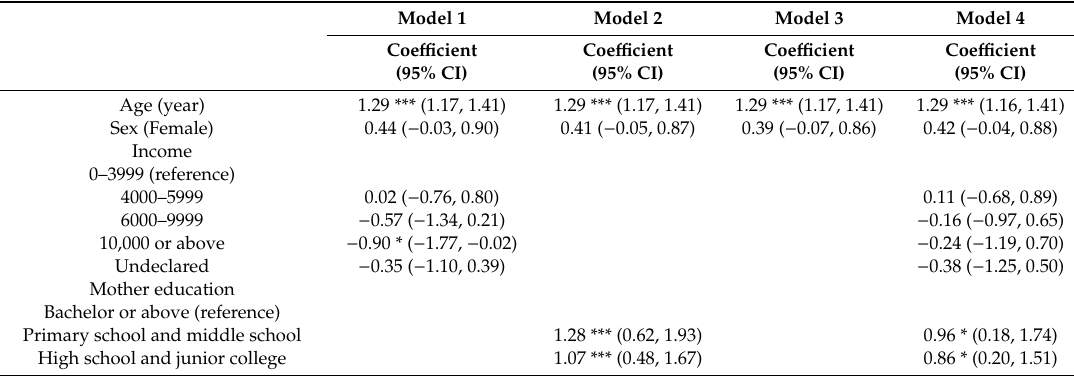
Table 2. Multilevel linear analysis of factors associated with changes in decayed, missing and filled teeth (DMFT) over one year among 772 preschool children in